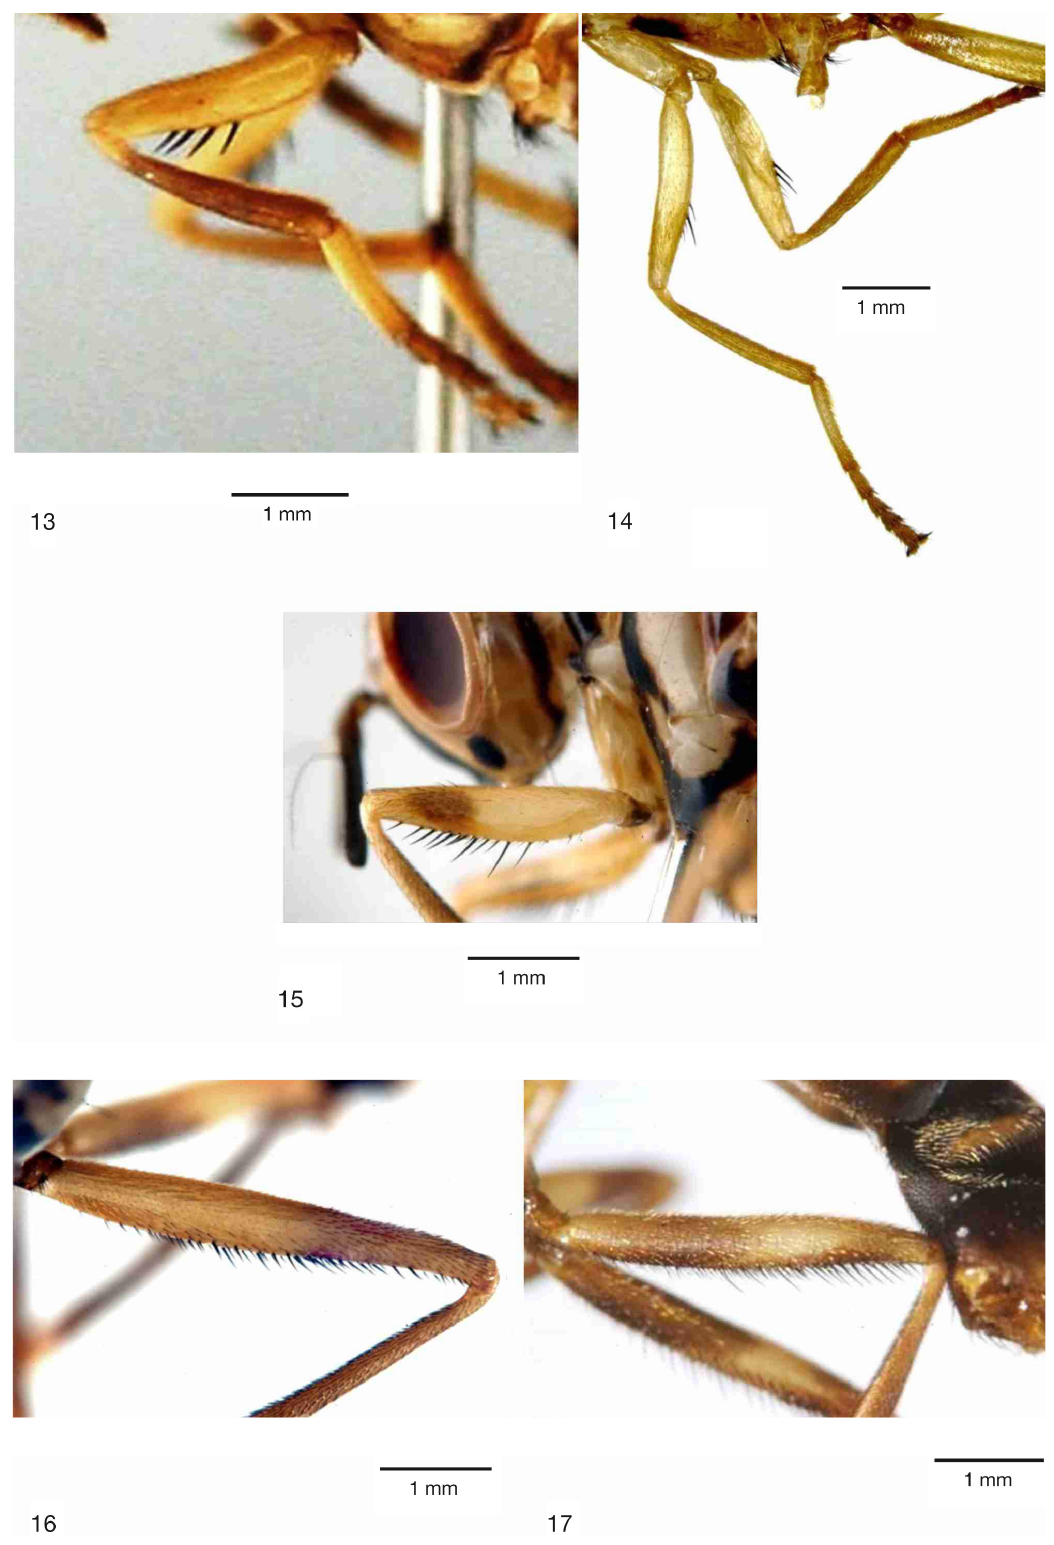
Figs 13–17. Ichneumonopsis spp., legs. 13 . I. burmensis Hardy, 1973, foreleg. 14 . I. taiwanensis sp. nov., foreleg. 15 . I. hancocki sp. nov., foreleg. 16 . I. hancocki sp. nov., midleg. 17 . I. hancocki sp. nov.,